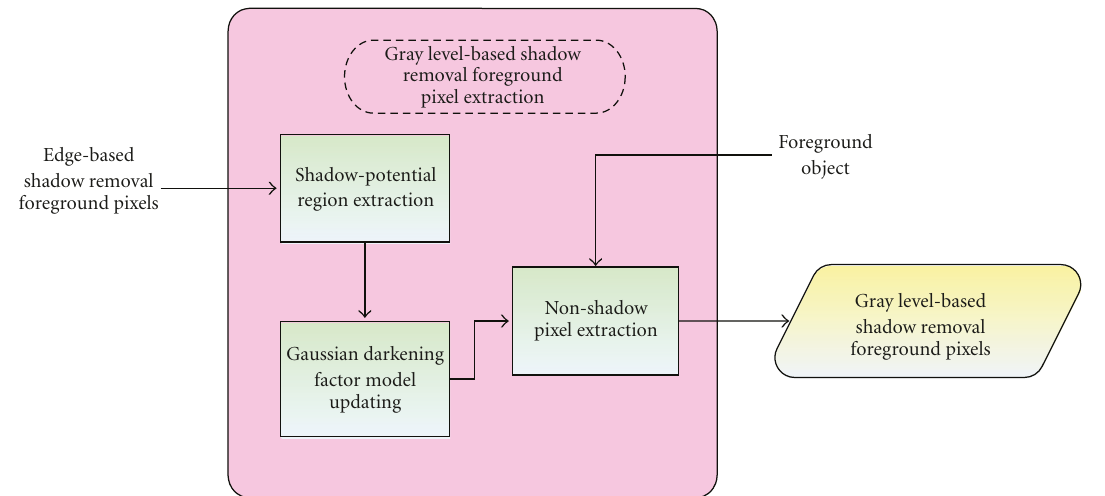
Figure 14: Flowchart of gray level-based shadow removal foreground pixel extraction.